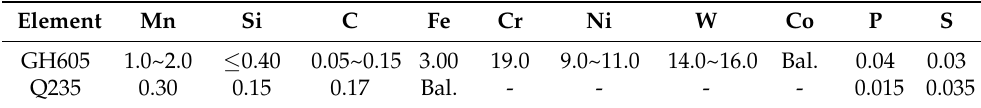
Table 1. The main chemical composition of the experimental materials (wt.%). Element